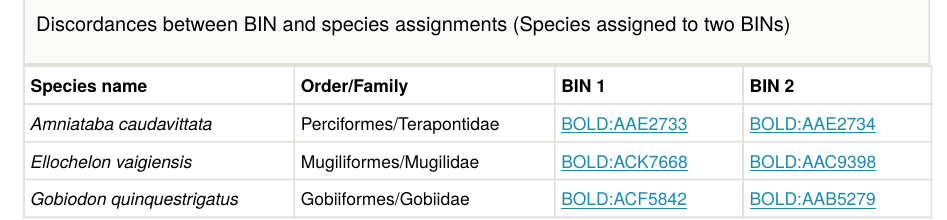
All sequences met the quality (<1% N) and length (>500 bp) criteria for BIN assignment, and were assigned to 375 BINs. There was perfect correspondence between the specimens assigned to a particular BIN and the members of a particular morphospecies in nearly all cases (372 of 375). The three exceptions each involved a BIN split with the members of a particular species assigned to two BINs (Table 2).